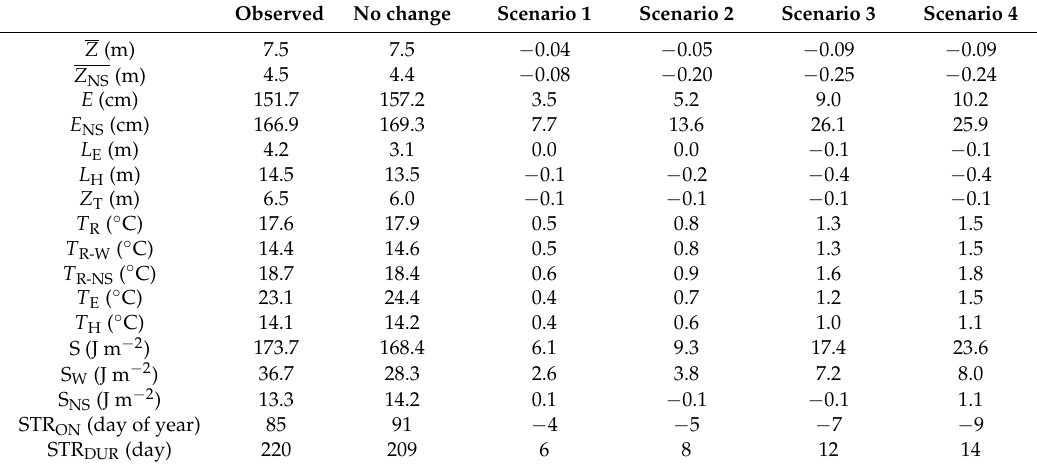
Table 2. Mean annual (January to December) or winter (November to March; denoted by a subscript “W”) reservoir characteristics simulated over the study period (1992 to 2011), excluding low water years (2002 to 2004). Means calculated for only low water years (2002 to 2004) are denoted by a subscript “NS”, indicating that there was no stratification in those years. Means include reservoir maximum ( Z and Z NS ) and mean ( Z and Z NS ) depth; evaporation ( E and E NS ); thicknesses of the epilimnion ( L E ) and hypolimnion ( L H ); depth of the thermocline ( Z T ); temperatures of the whole reservoir ( T R , T R-W , T R-NS ), epilimnion ( T E ), and hypolimnion ( T H ); Schmidt stability (S, S W , and S NS ); and onset (STR ON ) and duration (STR DUR ) of stratification. Values for warming scenarios (Scenarios 1 to 4) are differences relative to the reference run with no